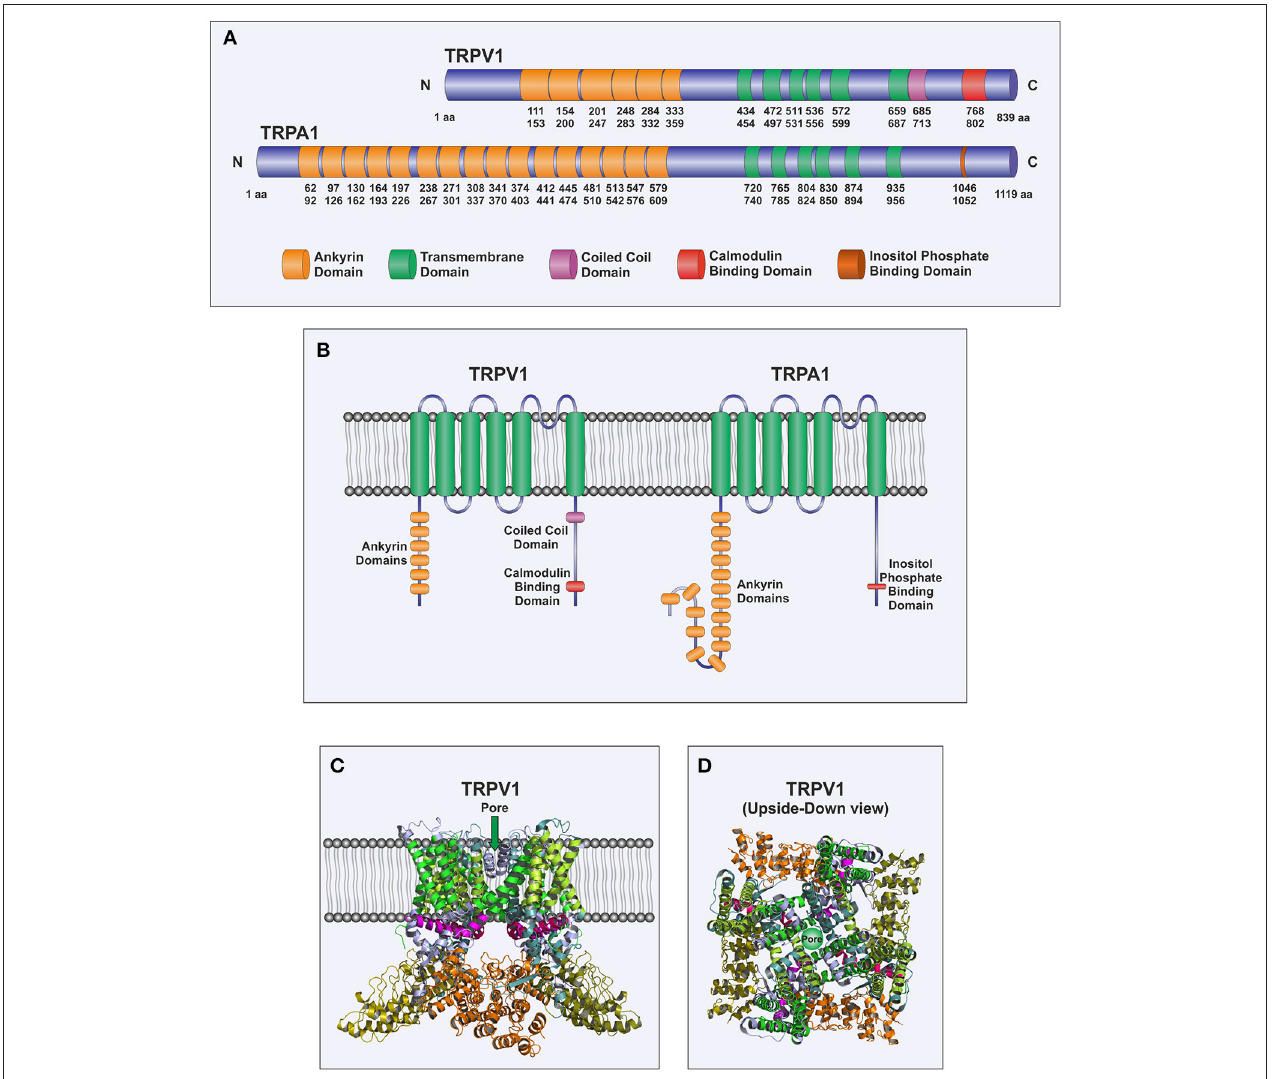
FIGURE 1 | Molecular structure of TRPA1 and TRPV1. (A) Scheme of TRPV1 and TRPA1 channels depicting individual domains. Numbers correspond to amino acids positions of human TRPV1 and TRPA1, respectively. (B) Cartoon representing TRPV1 and TRPA1 monomers morphology within a bilayer membrane. The channel spans the membrane up to six times with the pore located between transmembrane domains (TM) 5 and 6, and both N-terminal and C-terminal domains situated in the cytosol. (C,D) Cartoons depicting the tetrameric assembly of TRPV1 subunits based on the X-ray crystal structure of Rattus norvegicus as described in Cao et al. (2013). As mentioned above, the ion permeation pathway is formed by TM5 and TM6, while the remaining TM domains 1–4, surround the pore. (C) Represents a frontal view of the channel while (D) sketches an upside-down perspective.